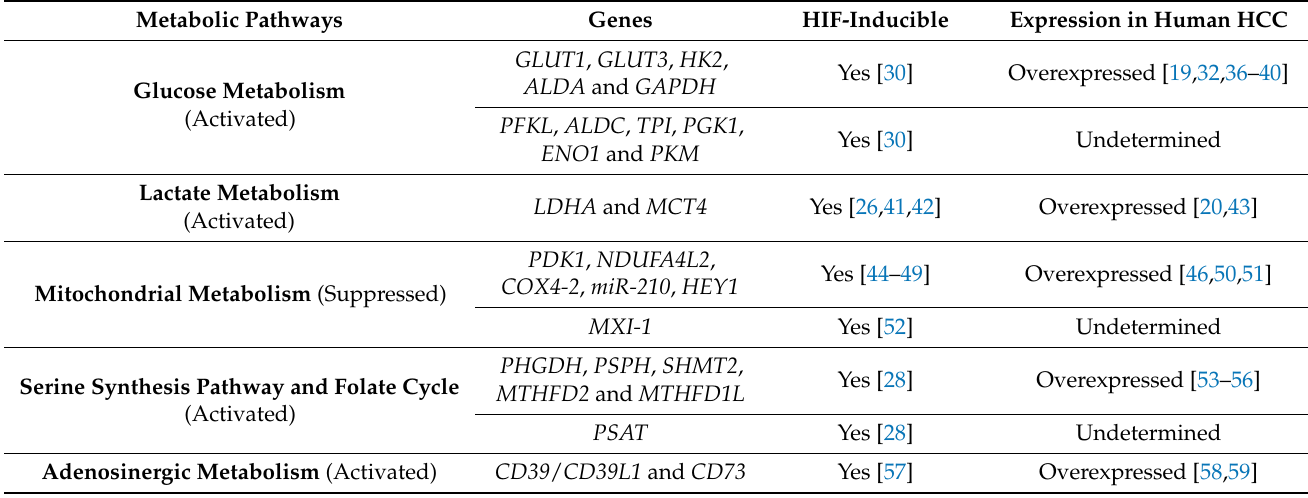
Table 1. Hypoxia-induced alterations of different metabolic pathways, their associated genes and their clinical relevance in human